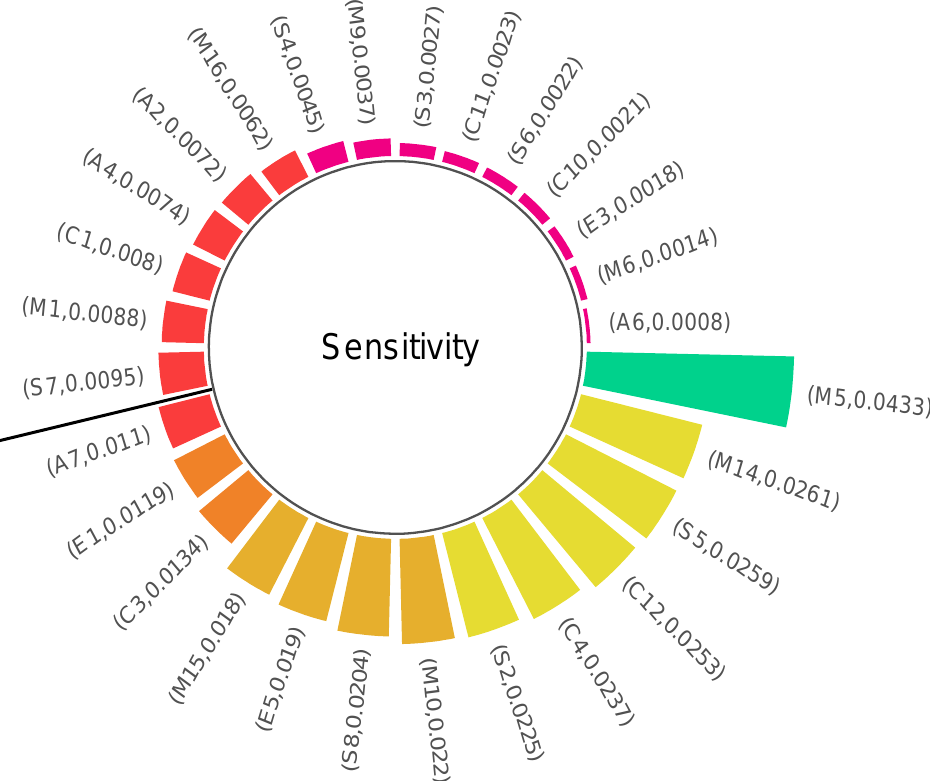
Figure 13. Sensitivity of safety risk